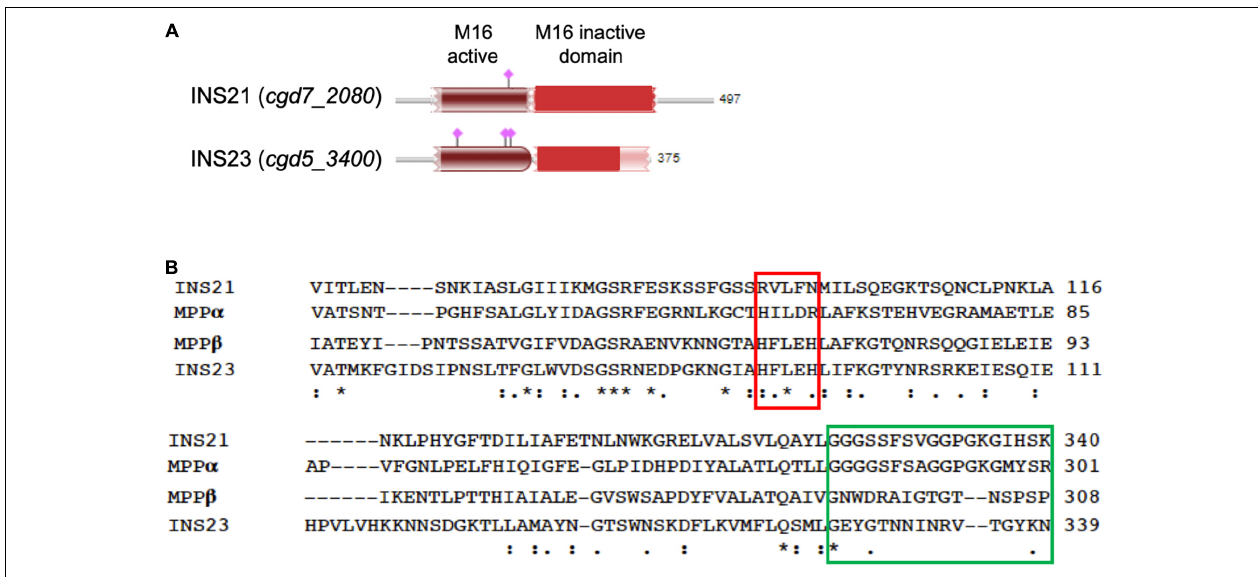
FIGURE 1 | Sequence features of INS-21 and INS-23 of Cryptosporidium parvum . (A) Diagram of INS-21 (encoded by cgd7_2080) and INS-23 (encoded by cgd5_3400) of C. parvum . (B) Alignment of partial amino acid sequences of INS-21, INS-23 of C. parvum , and the α and β subunits of the mitochondrial processing peptidase (MPP) from Starmerella bombicola (yeast). Residues shown in the red box indicate the zinc-binding motif of the M16 family in MPP β , while those in the green box represent the glycine-rich loop in MPP α . Thus, INS-23 contains the zinc-binding motifs while INS-21 contains the glycine-rich loop, indicating that both might act in concert in function. “*” indicates identical amino acid residue; “:” indicates high similarity; “.” indicates low similarity.